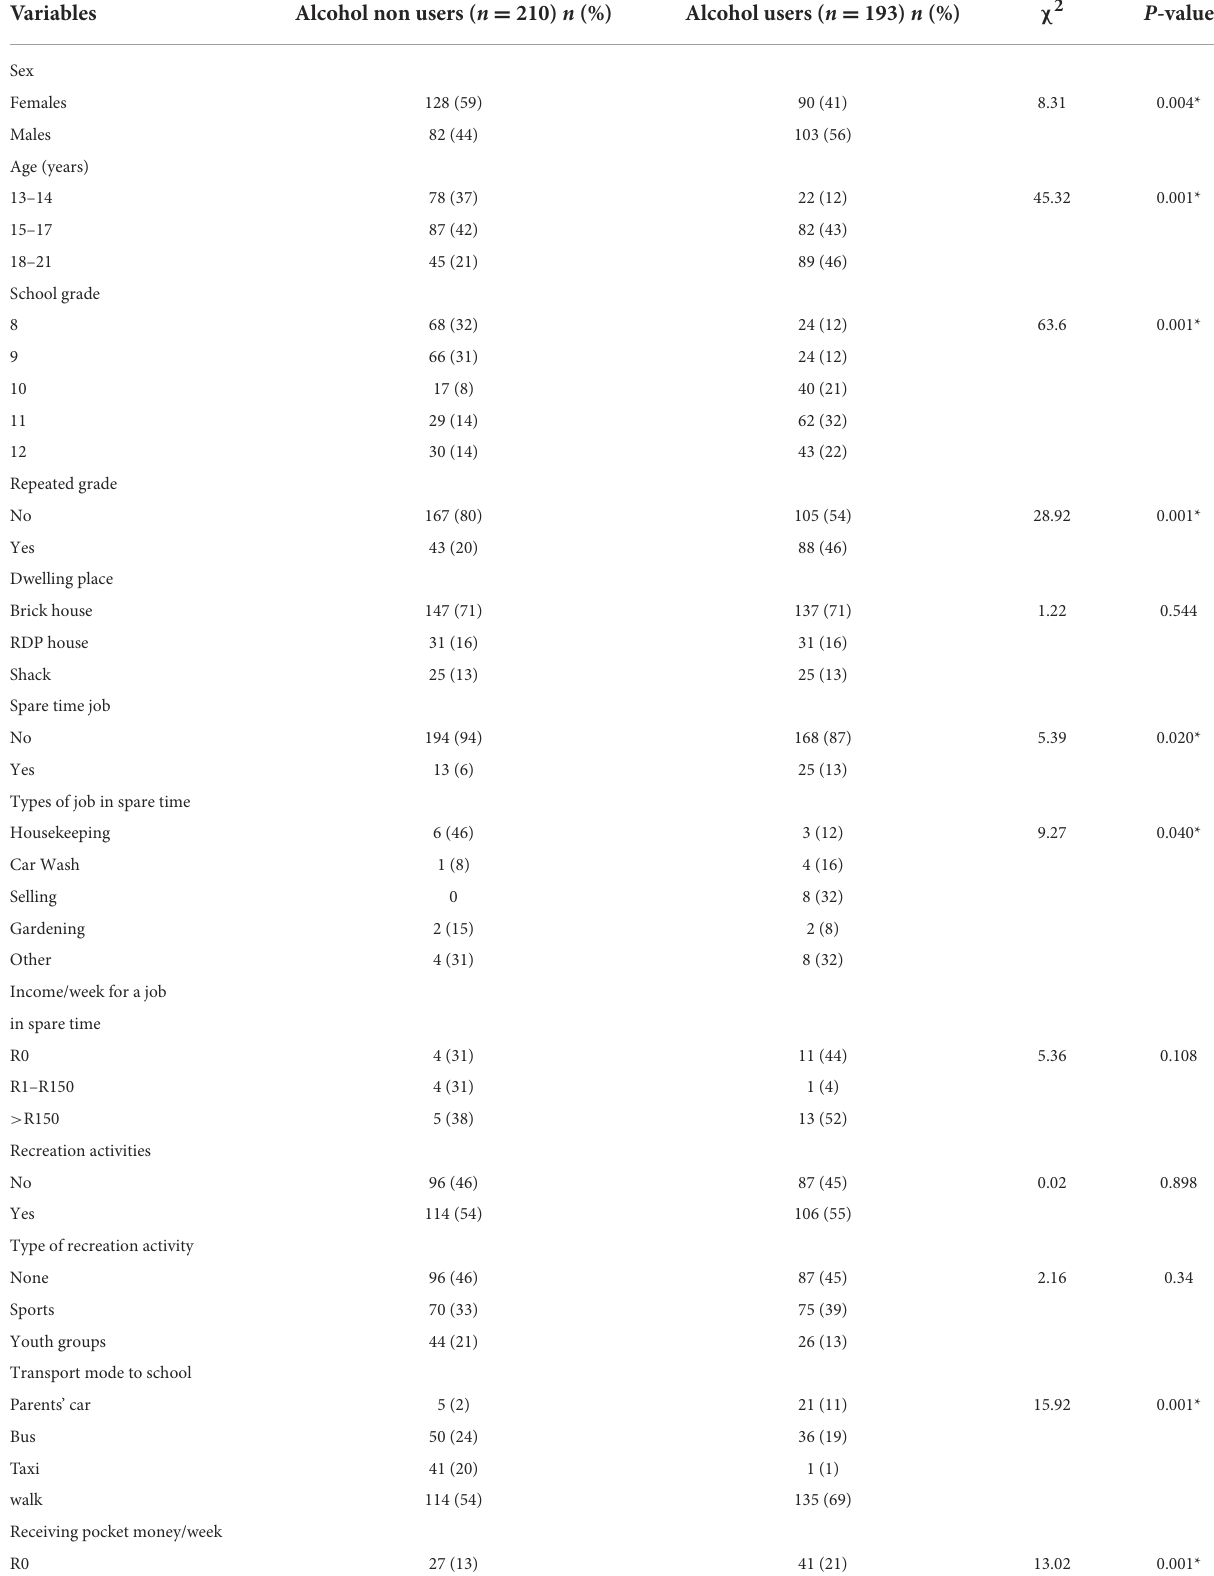
TABLE 3 Comparison of characteristics of adolescents by current alcohol